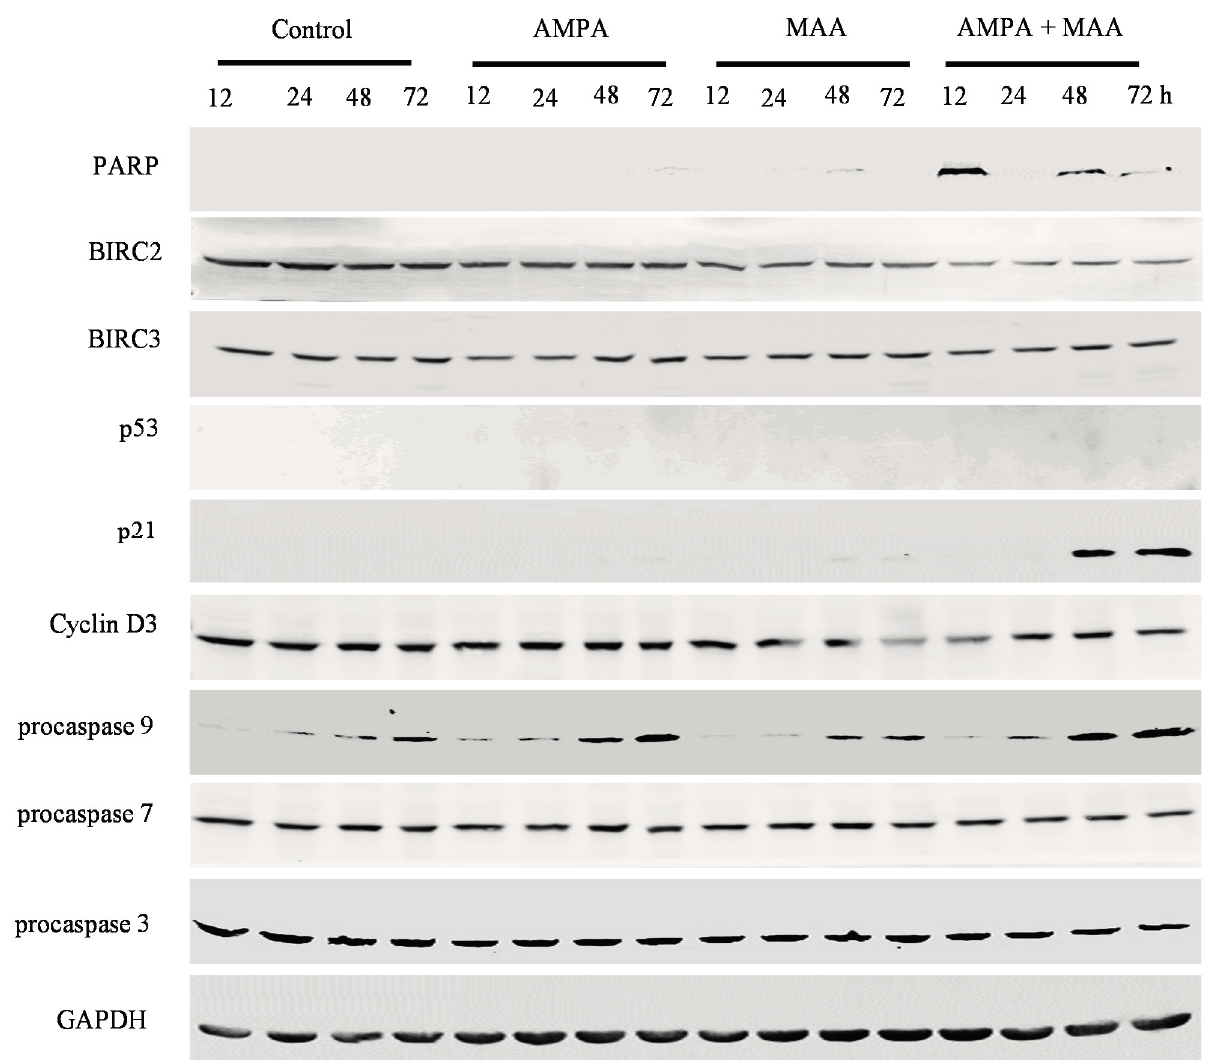
Figure 6. AMPA and MAA induce changes in the expression levels of genes involved in cell cycle arrest and apoptosis. PC-3 cells were exposed to 15 mM AMPA, 5 mM MAA or a combination of both AMPA and MAA for different time periods. The protein extracts were analyzed by Western blot to detect the indicated proteins. GAPDH was probed as the loading